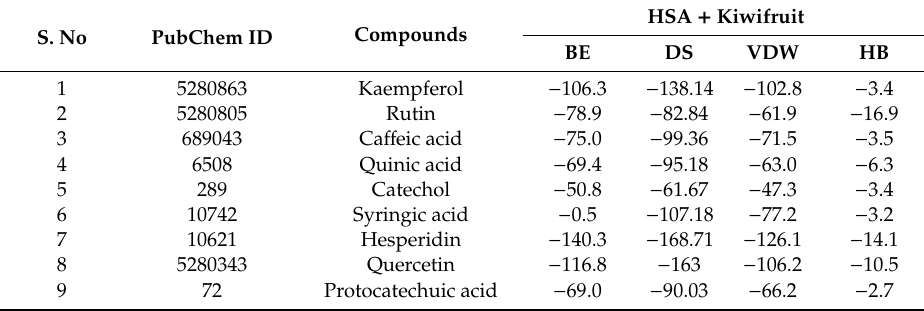
Table 3. The ligands from kiwifruit showing interaction with HSA represented with binding energy (BE), dock score (DS), van der Waals (VDW) and H-bond (HB) energy. S.